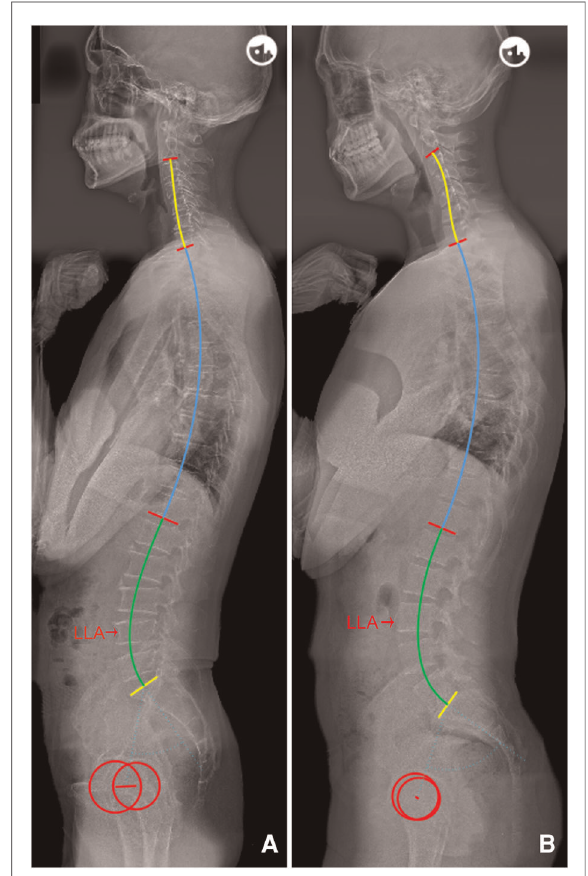
FIGURE 5 ( A ) Male, 55 years old, PI=44.8°, IP=12; LLA=16, LASO=46.7 mm, LLL=35.0°, ULL=25.2°, and LL=60.2°. ( B ) Male, 23 years old, with the same IP (12) as a, but with a higher PI (72.2°); LLA=15, LASO =60.2 mm, LLL=53.2°, ULL=25.3°, and LL=78.5°. PI, pelvic incidence; IP, in fl ection point; LLA, apex of lumbar lordosis; LASO, the horizontal offset between the plumb line of the lumbar apex and that of the posterosuperior corner of S1; LLL, lower lumbar lordosis; ULL, upper lumbar lordosis; LL, lumbar